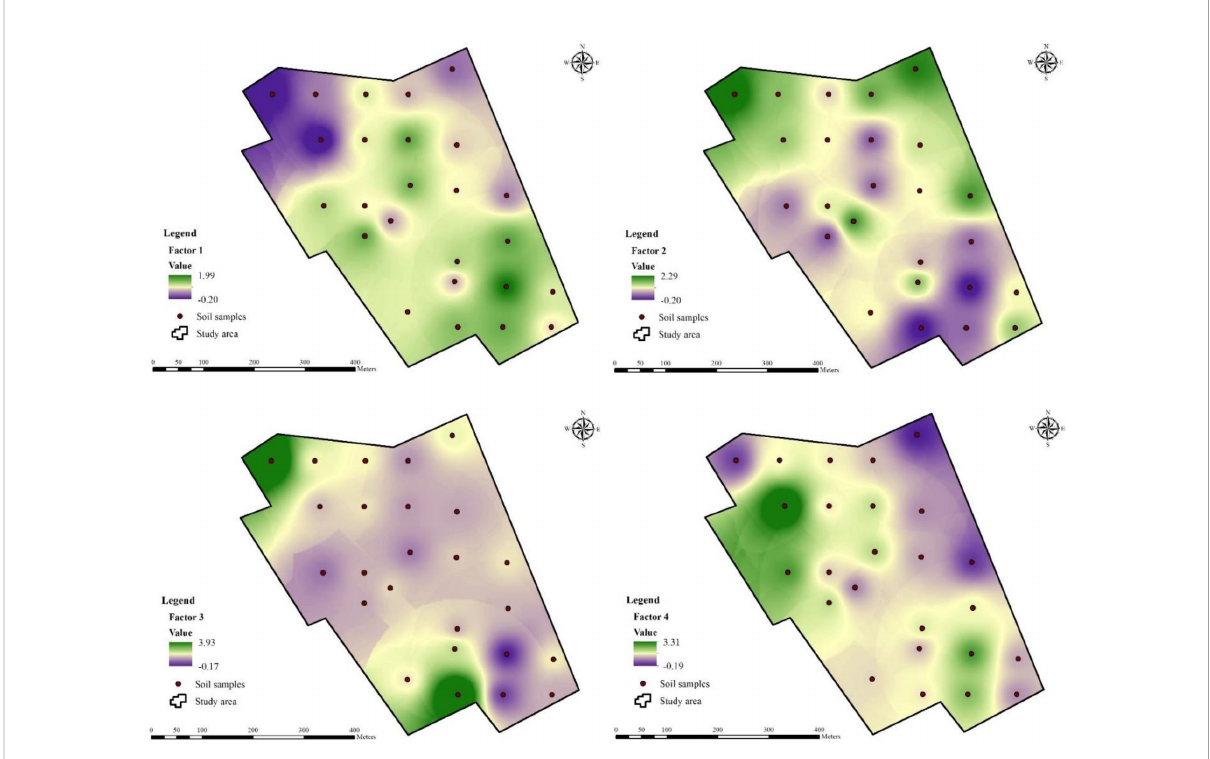
FIGURE 10 Spatial variations for the normalization from each of the four factors within the agricultural